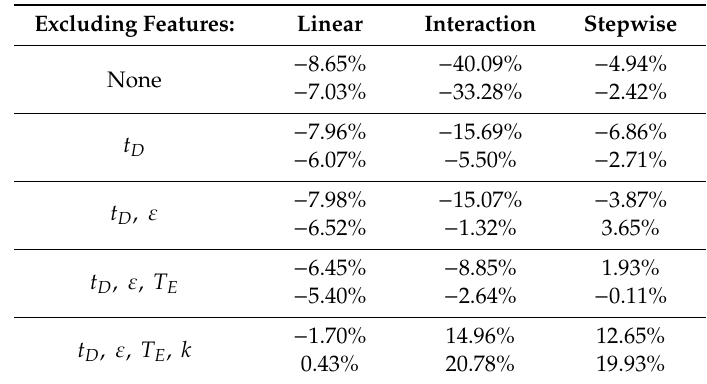
Table 4. Variation of MAE (100 sets of values) when “Contrast Rear” is excluded as predictive feature MAE without ∆ TR − MAE with ∆ TR × calculated as: MAE with ∆ TR